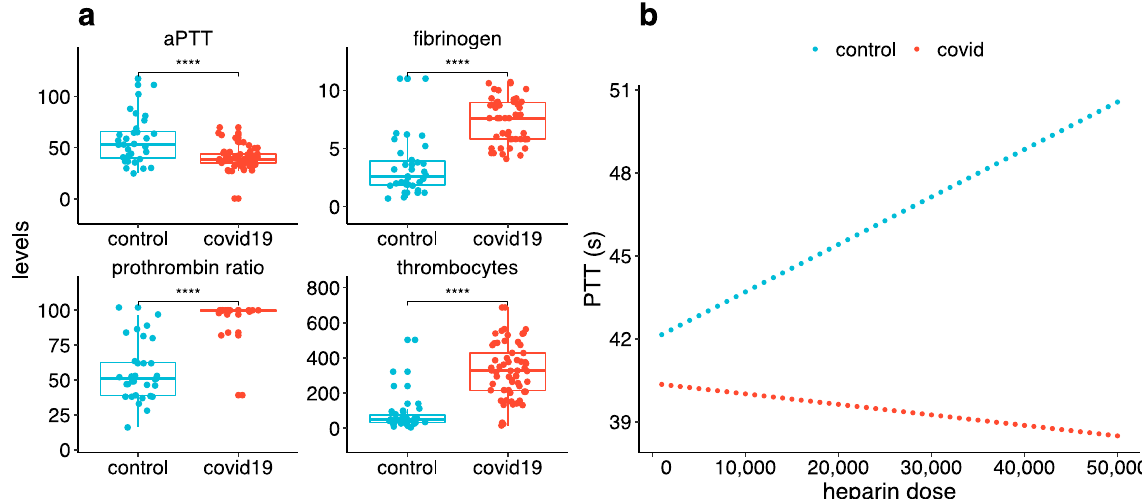
Figure 3. Coagulation profile in COVID-19 (red) and control (blue) groups. ( a ) aPTT level in seconds, fibrinogen level in g/L, prothrombin ration in percentages and thrombocytes level in G/L. ( b ) Simulated aPTT (seconds) according to heparin cumulative dose (UI) in COVID-19 (red) and control (blue) groups. **** p < 0.0001.